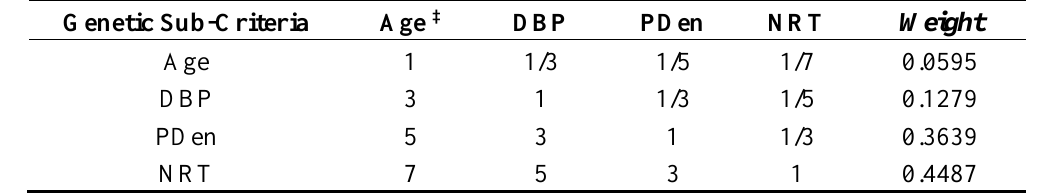
Table 4. Pairwise comparison matrix and relative weights of genetic sub-criteria used to estimate the degree of risk of the populations of Pseudotsuga menziesii in central México † .